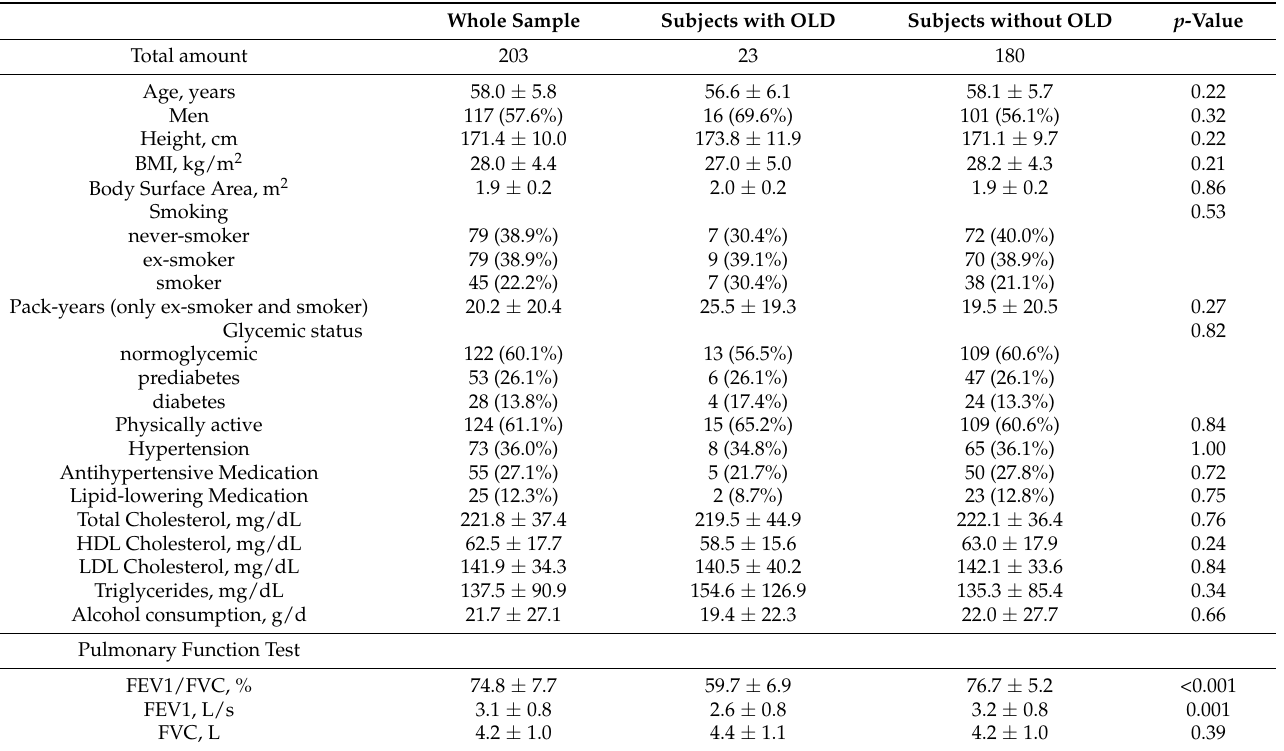
Table 1. Characteristics of the study sample.